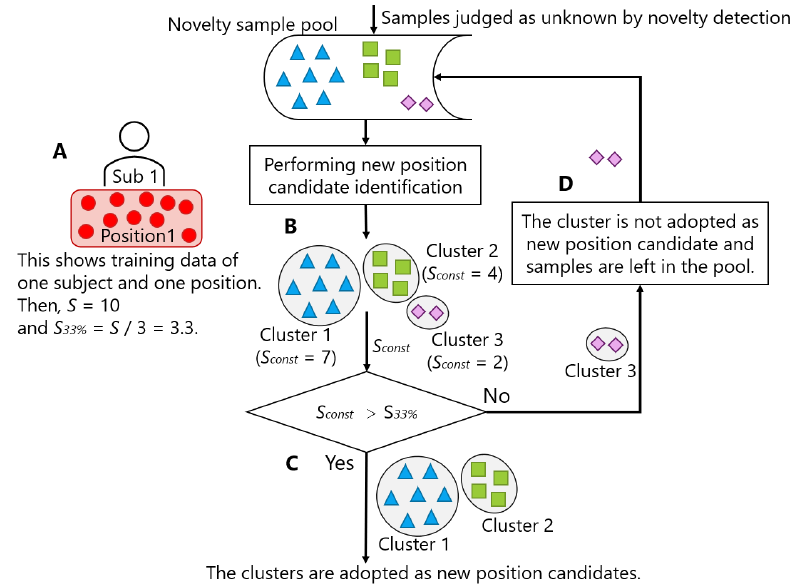
Figure 14. Process of deciding whether to adopt the result of new position candidate identification.